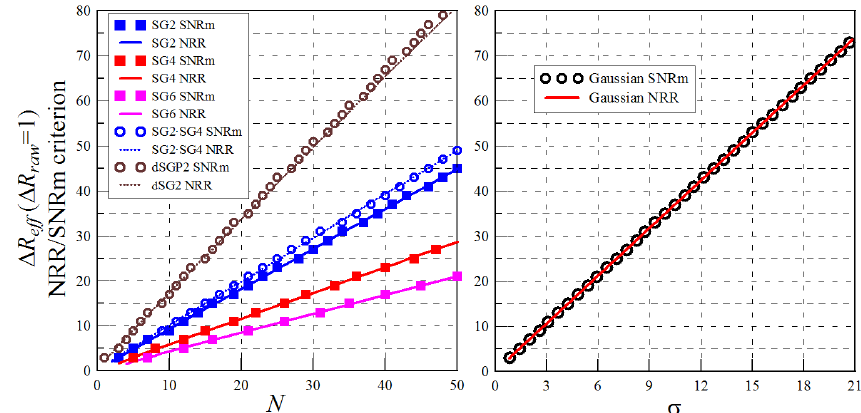
Figure 12. Left panel: the ERes estimated as a function of N with the NRR criterion (solid lines) and with the SNR matching criterion (SNRm, dotted lines) are shown for different SG smoothing filters. The ERes values for the SG2 + Blk filter are not shown and they are between the SG2 and the SG2 · SG4 curves. Right panel: the ERes using the Gaussian filter with different σ . Note that the NRR and SNRm criteria give almost the same